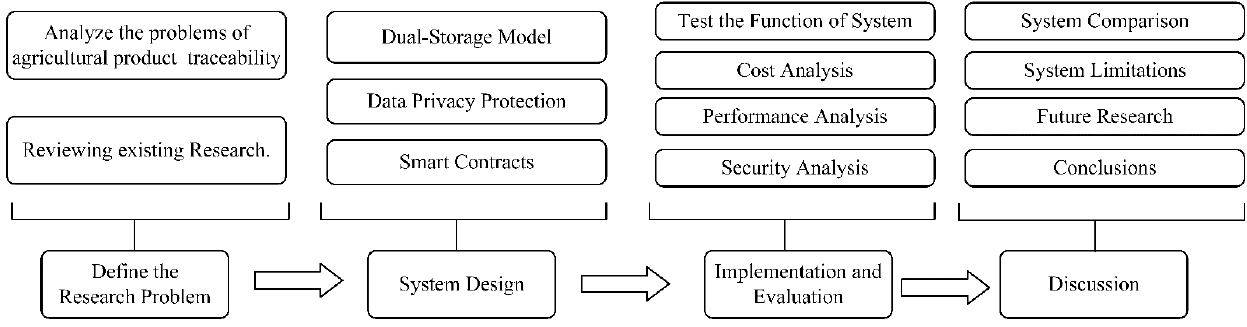
Figure 1. The flow of research stages.